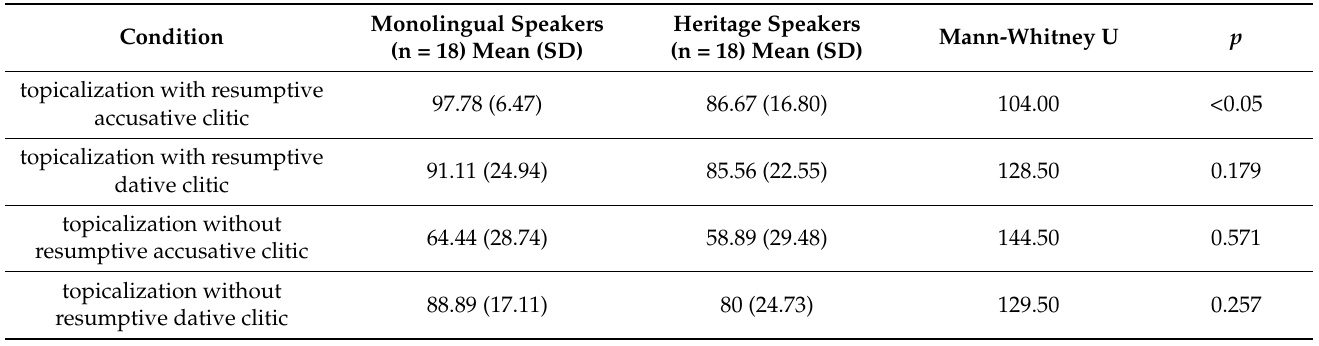
Table 5. Topicalization: Mean of accuracy rate, SD, statistical significance (Mann–Whitney U-test) (adapted from (Rinke and Flores 2014, p.